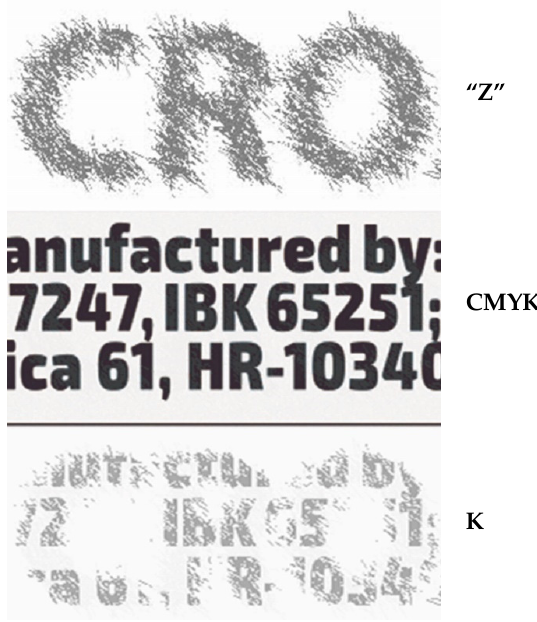
Figure 4. Letters within letters “CRO”.